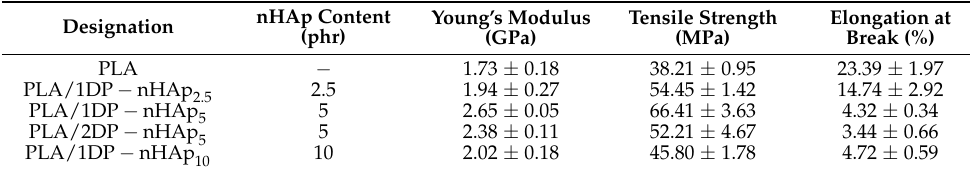
Table 2. Mechanical properties of PLA/nHAp composite films with nHAp from different steps of preparation and 1DP-nHAp at various contents.